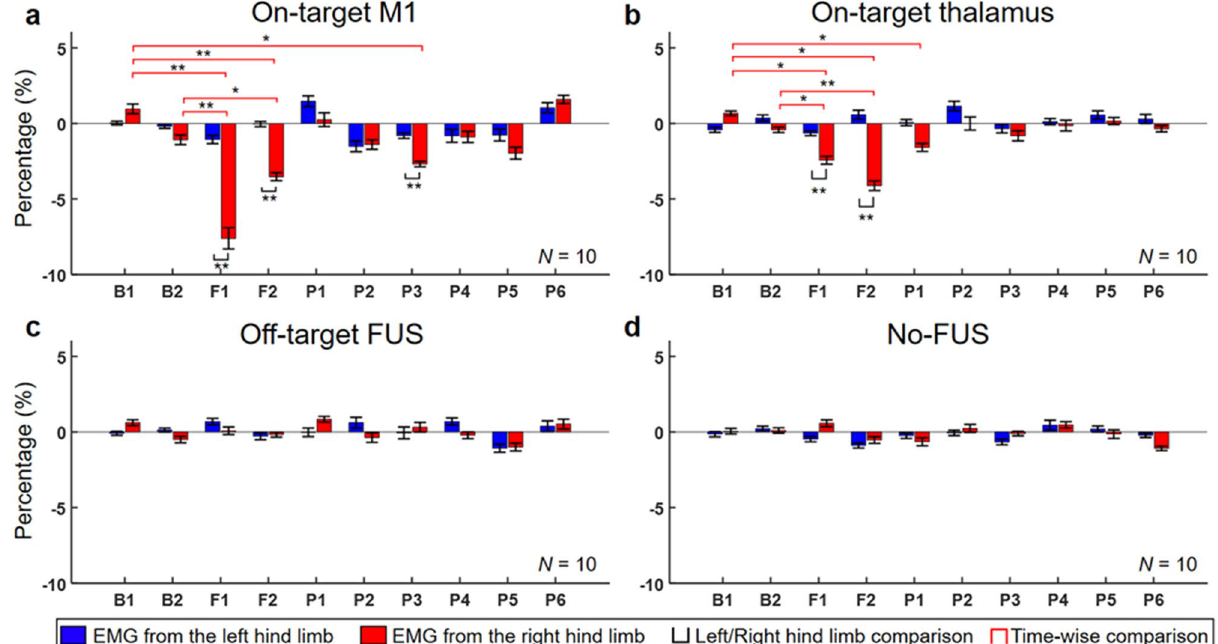
after (P1–P6) suppressive sonication to ( a ) the M1, ( b ) the thalamus, ( c ) the off-target area, and ( d ) data from no-FUS condition ( N = 10 sheep). A one-way repeated measures ANOVA ( P ≤ 0.001 for the right hind limb with on-target M1/thalamus conditions) with Tukey–Kramer post-hoc analysis for multiple comparisons was conducted to analyze the time-dependent differences in the amplitude obtained from each hind limb (left, blue bar; right, red bar). No statistical differences were shown from the right hind limb during off-target and no-FUS conditions, and from the left hind limb during all the experimental conditions. To compare the difference in